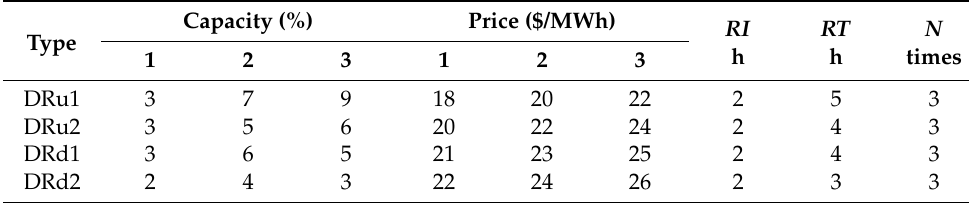
Table A4. Parameters of incentive demand